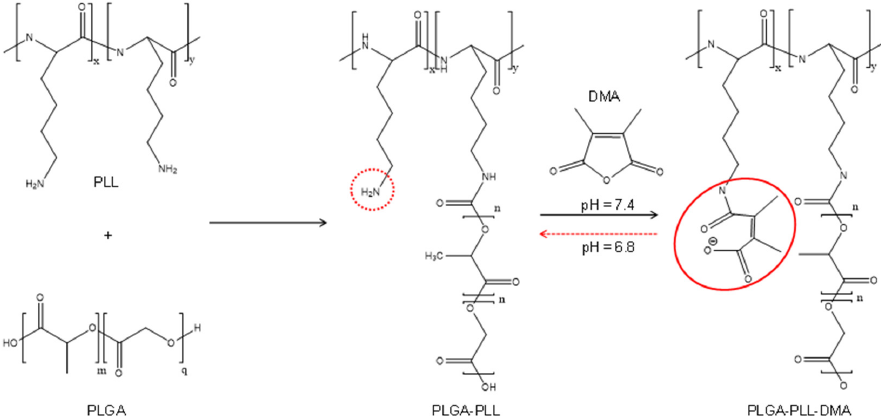
Figure 2. Scheme of synthesis of the PLGA-PLL-DMA copolymer. The continuous red line ring ev- idences the formation of β -carboxyamide bond which can be hydrolyzed at pH 6.8 in NH 2 (red dot- ted line ring) and